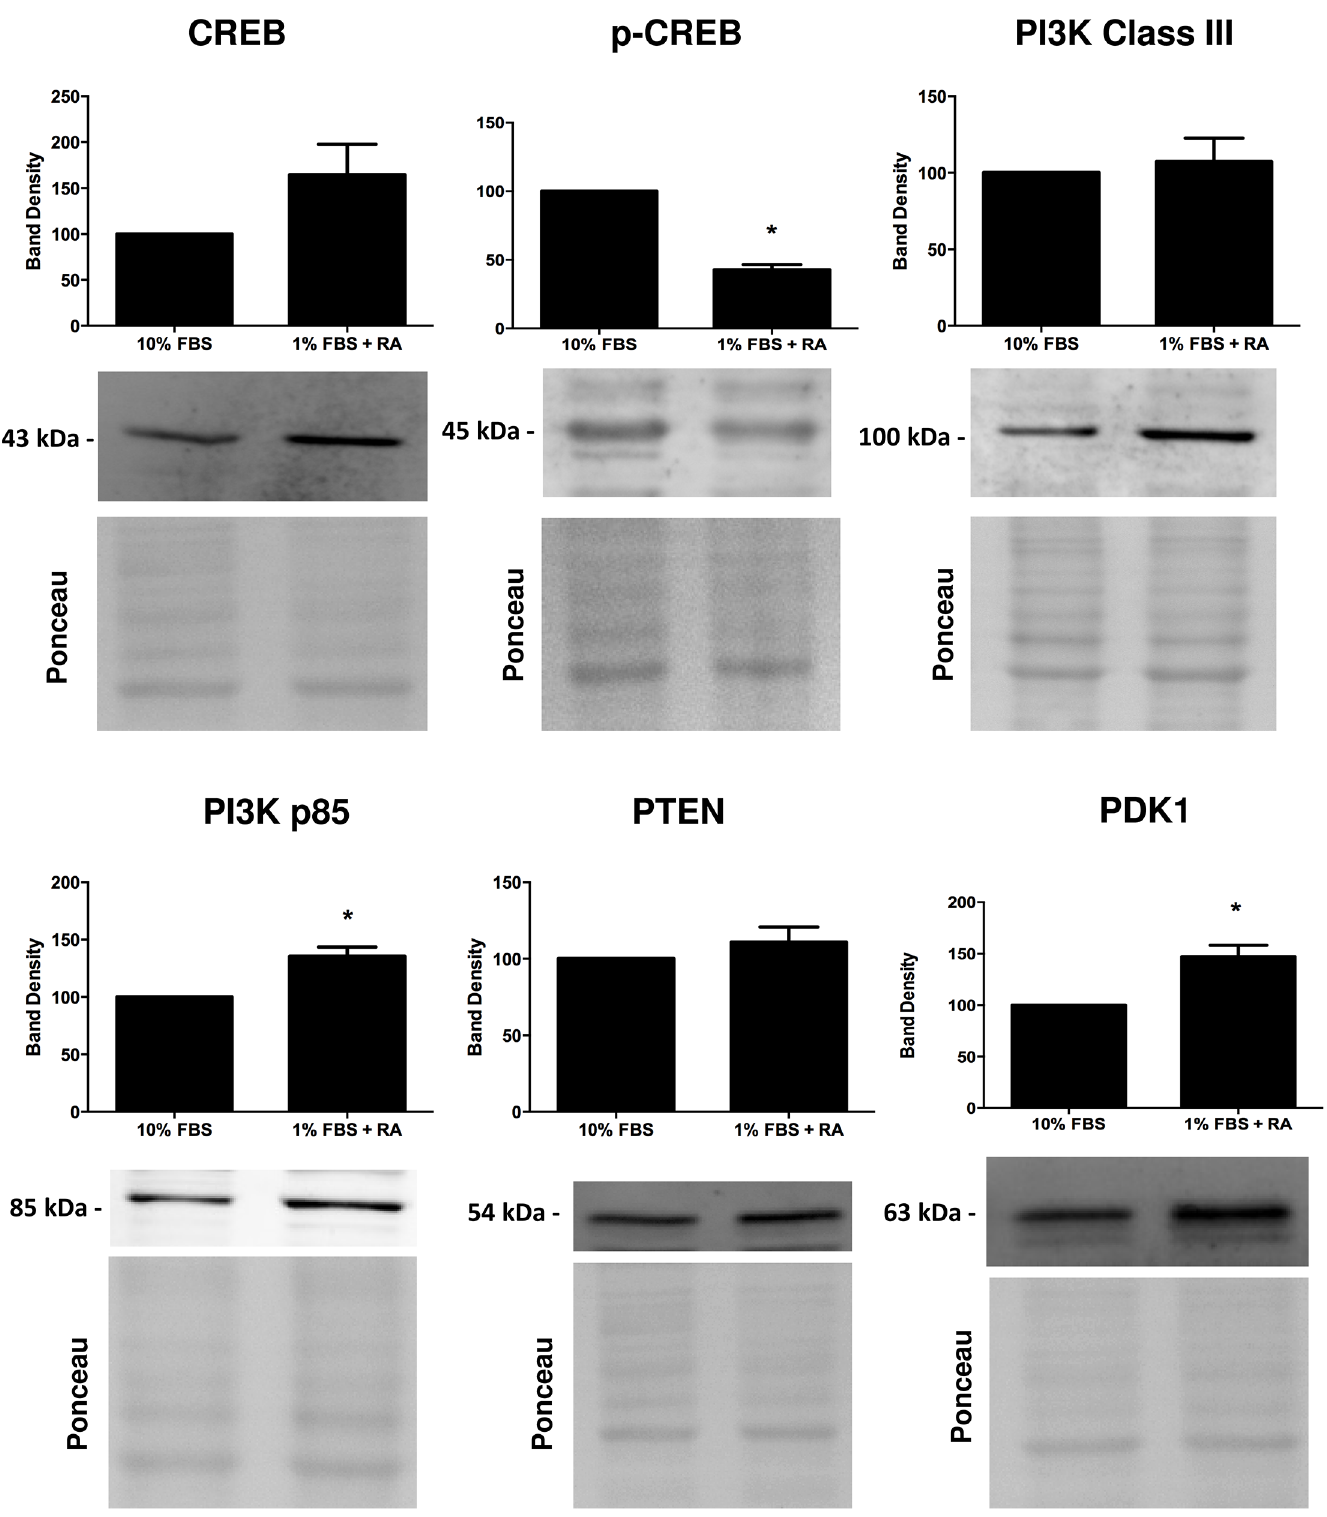
Fig 4. Evaluation by Western blotting of selected proteins with probable involvement on the differentiation of H9c2 cells towards a cardiac-like cells. Cellular content of Creb (total and phosphorylated form), PI3K (Class III and p85), PTEN and PDK1were measured as described in the materials and methods section. Ponceau labeling represents the loading control and was used to normalize data. Data represent the mean ± SEM of 4 independent experiments ( * ) p < 0.05 vs undifferentiated group.